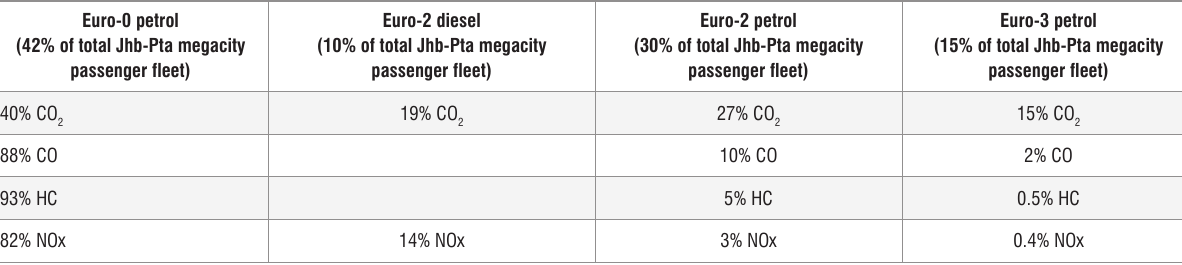
Input data for the Johannesburg-Pretoria (Jhb-Pta) megacity model run Euro-0 petrol (42% of total Jhb-Pta megacity passenger